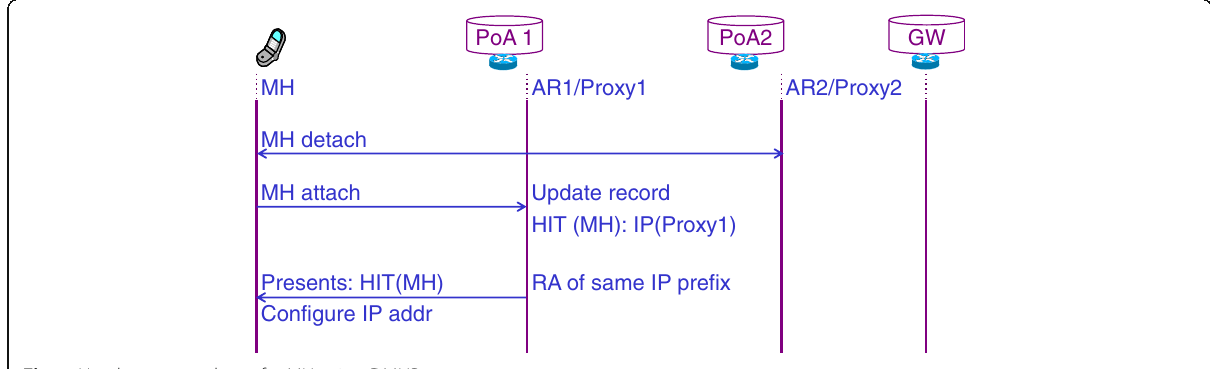
Fig. 7 Handover procedure of a MH using